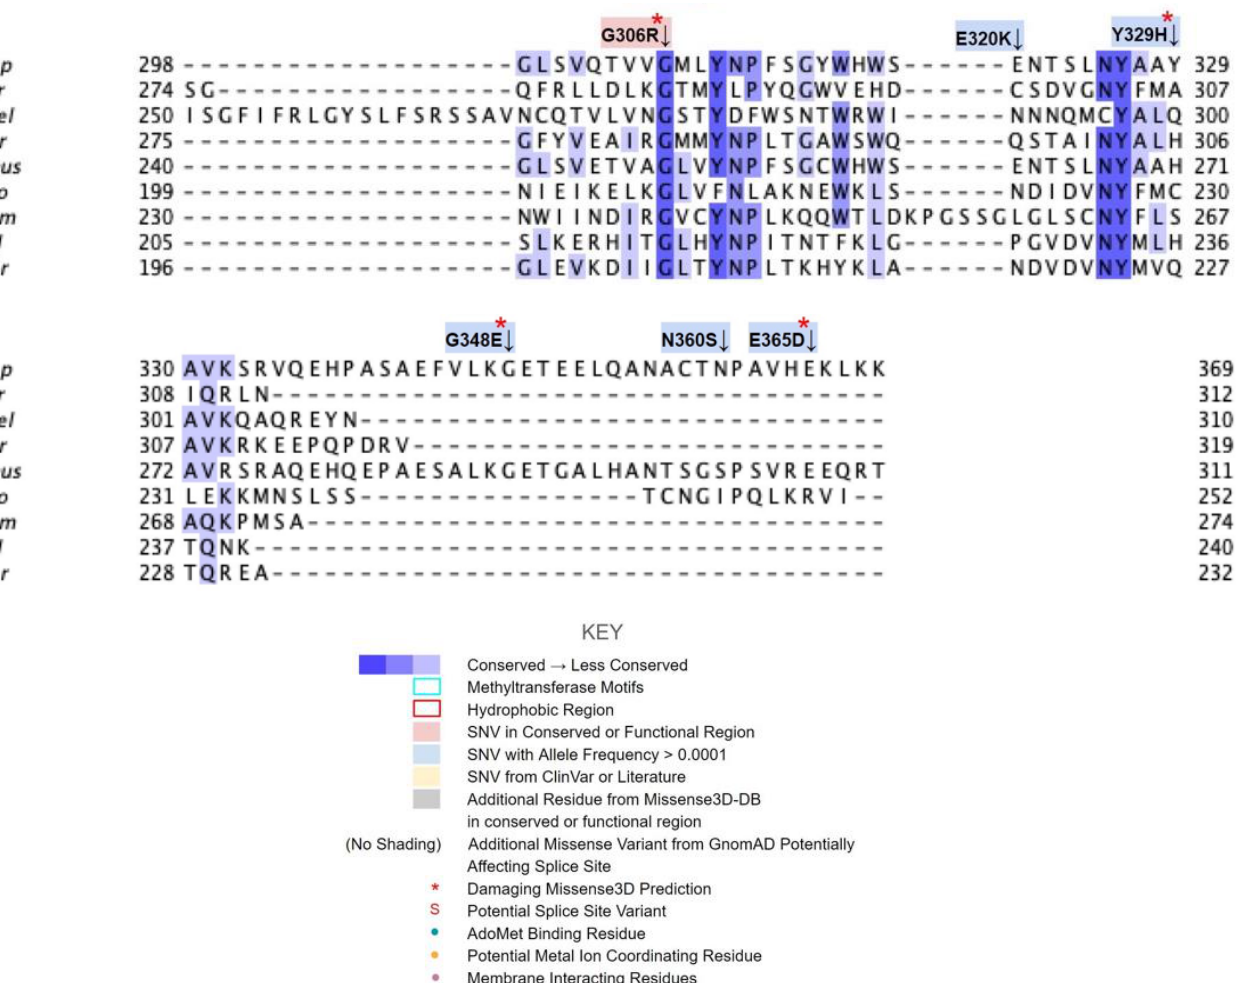
Figure 3. Labeled and annotated multiple sequence alignment of COQ3. Amino acid sequences of COQ3 were analyzed as described in Materials and Methods and include Homo sapiens (NCBI accession number NP_059117.3) and homologs in Saccharomyces cerevisiae (NP_014545), Drosophila melanogaster (NP_610092.2), Danio rerio (NP_001002620.1), Mus musculus (NP_766275.1), Rickettsia prowazekii (WP_004596275.1), Schizosaccharomyces pombe (NP_588239.2), Escherichia coli (NP_416735.1), and Pseudomonas aeruginosa (WP_003122245.1). See KEY for descriptions of the figure annotations. Putative AdoMet binding residues are denoted by a blue dot, and residues thought to interact with the cell membrane in E. coli UbiG are denoted by a purple dot, data from [45,46]. A pair of co-evolving, highly conserved, and structurally nearby histidines may be involved in metal ion coordination (orange dot), data from [63]. Methyltransferase motifs I, post-I, II, and III are boxed in cyan data from [56,64]. The putative membrane-interacting hydrophobic region is boxed in red, data from [45]. For all multiple sequence alignments, conservation is indicated via shaded residues, which represent a percent identity great than 80%, 60%, and 40%, from darkest to lightest. Residues with less than 40% identity are